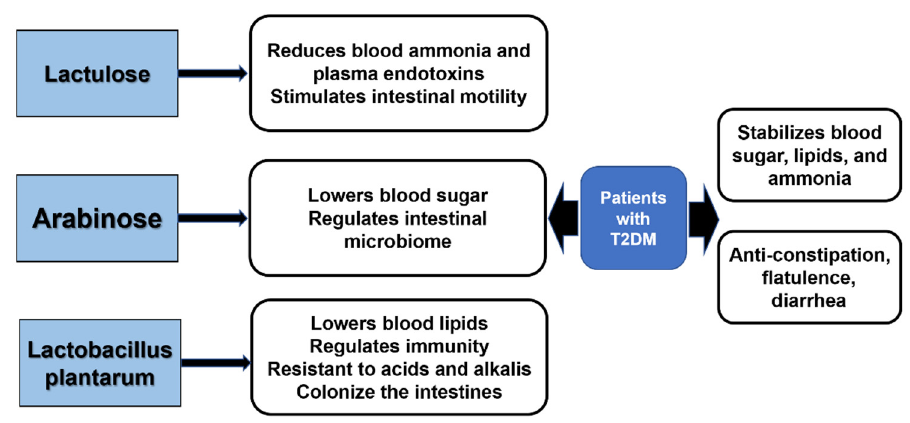
Figure 3. Effect of lactulose, arabinose, and Lactobacillus plantarum in the treatment of T2DM.